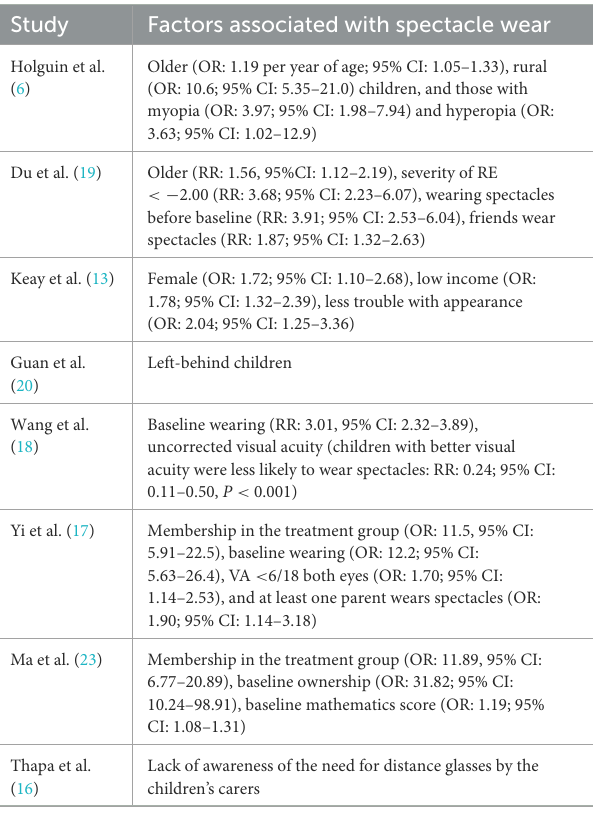
TABLE 2 Reasons for compliance with spectacle